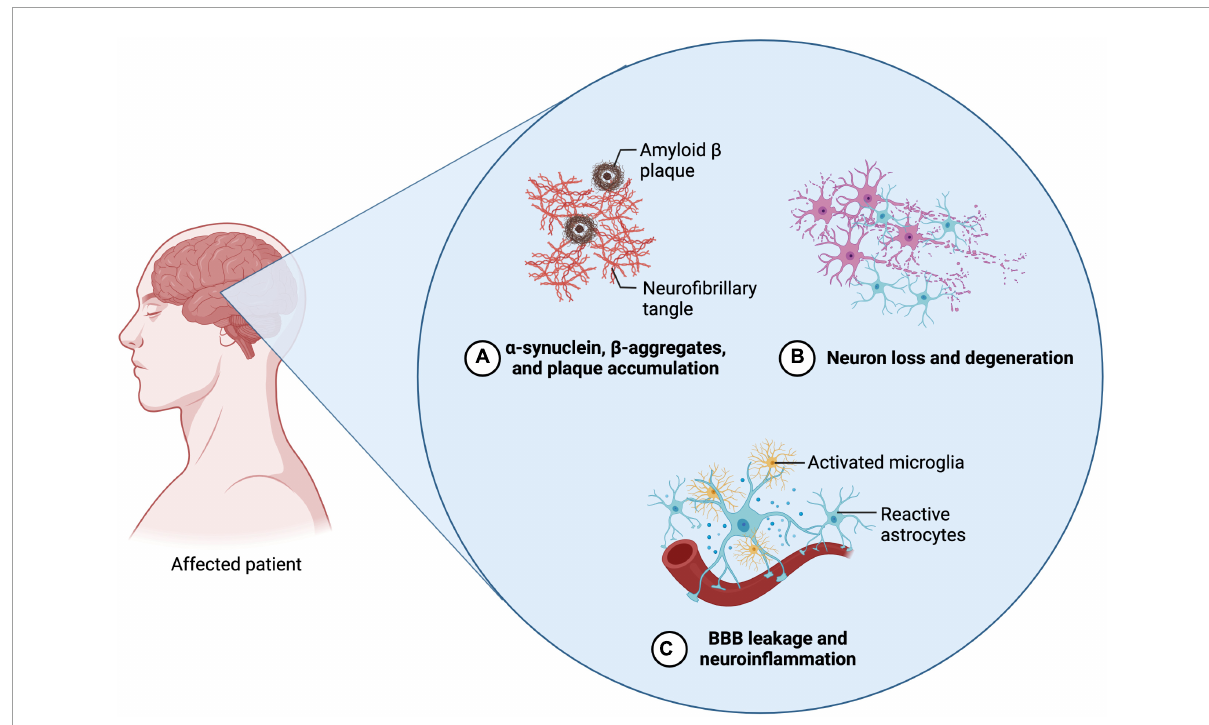
FIGURE3 Neuropathological features of Parkinson’s disease (PD) and Alzheimer’s disease (AD). The two diseases exhibit similar neuropathological features. (A) The emergence of abnormal protein depositions can thereby be observed during the initial phases of both diseases. In regard to AD, β -amyloid plaques and Tau protein accumulations can be found, whereas in PD α -synuclein aggregates. (B) The abnormal accumulation then leads to the induction of apoptosis and the decline of the according neuronal cells. Regarding AD, primarily neurons in the area of the cortex and the hippocampus are affected. In PD, mainly dopaminergic neurons in the substantia nigra are affected (C) Alongside the progressive neuronal cell decline, neuroinflammation and the disruption of the blood-brain barrier can be observed, which is accompanied by their pathognomonic symptoms (Created with